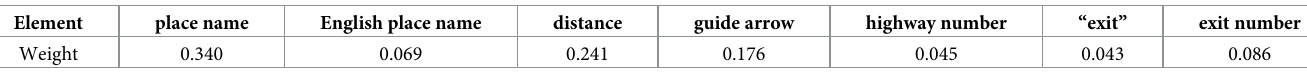
Table 7. Weight of each element of highway exit advance guide sign.